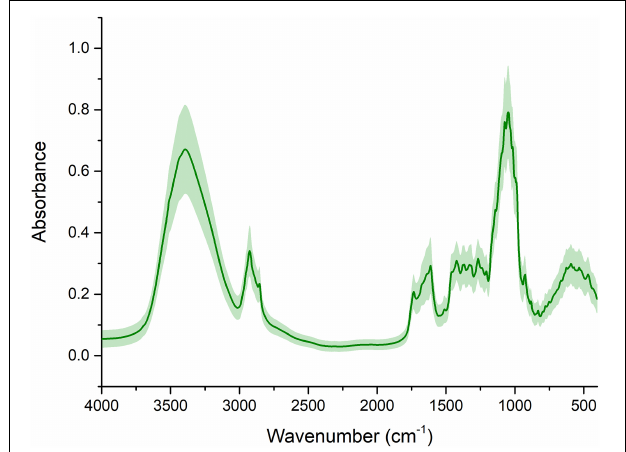
FIGURE 2 | The raw FT-IR spectra. The line represents the average spectra of wild G. rigescens , and the shade around the average spectra represents the standard